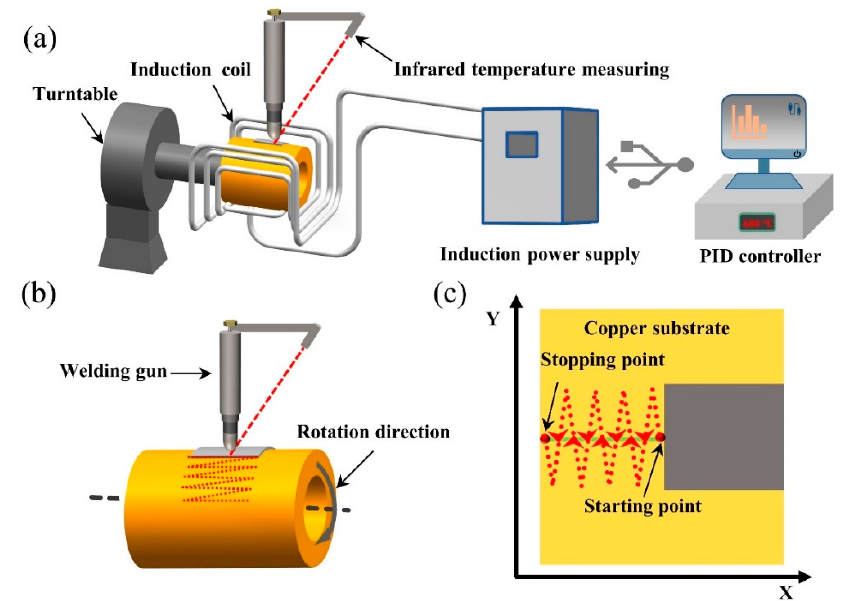
Figure 3. ( a ) Schematic diagram of the cladding system, ( b ) detail view of the swinging arc plasma cladding process and ( c ) magnified view of swinging arc path. Table 2. Cladding parameters of swing arc